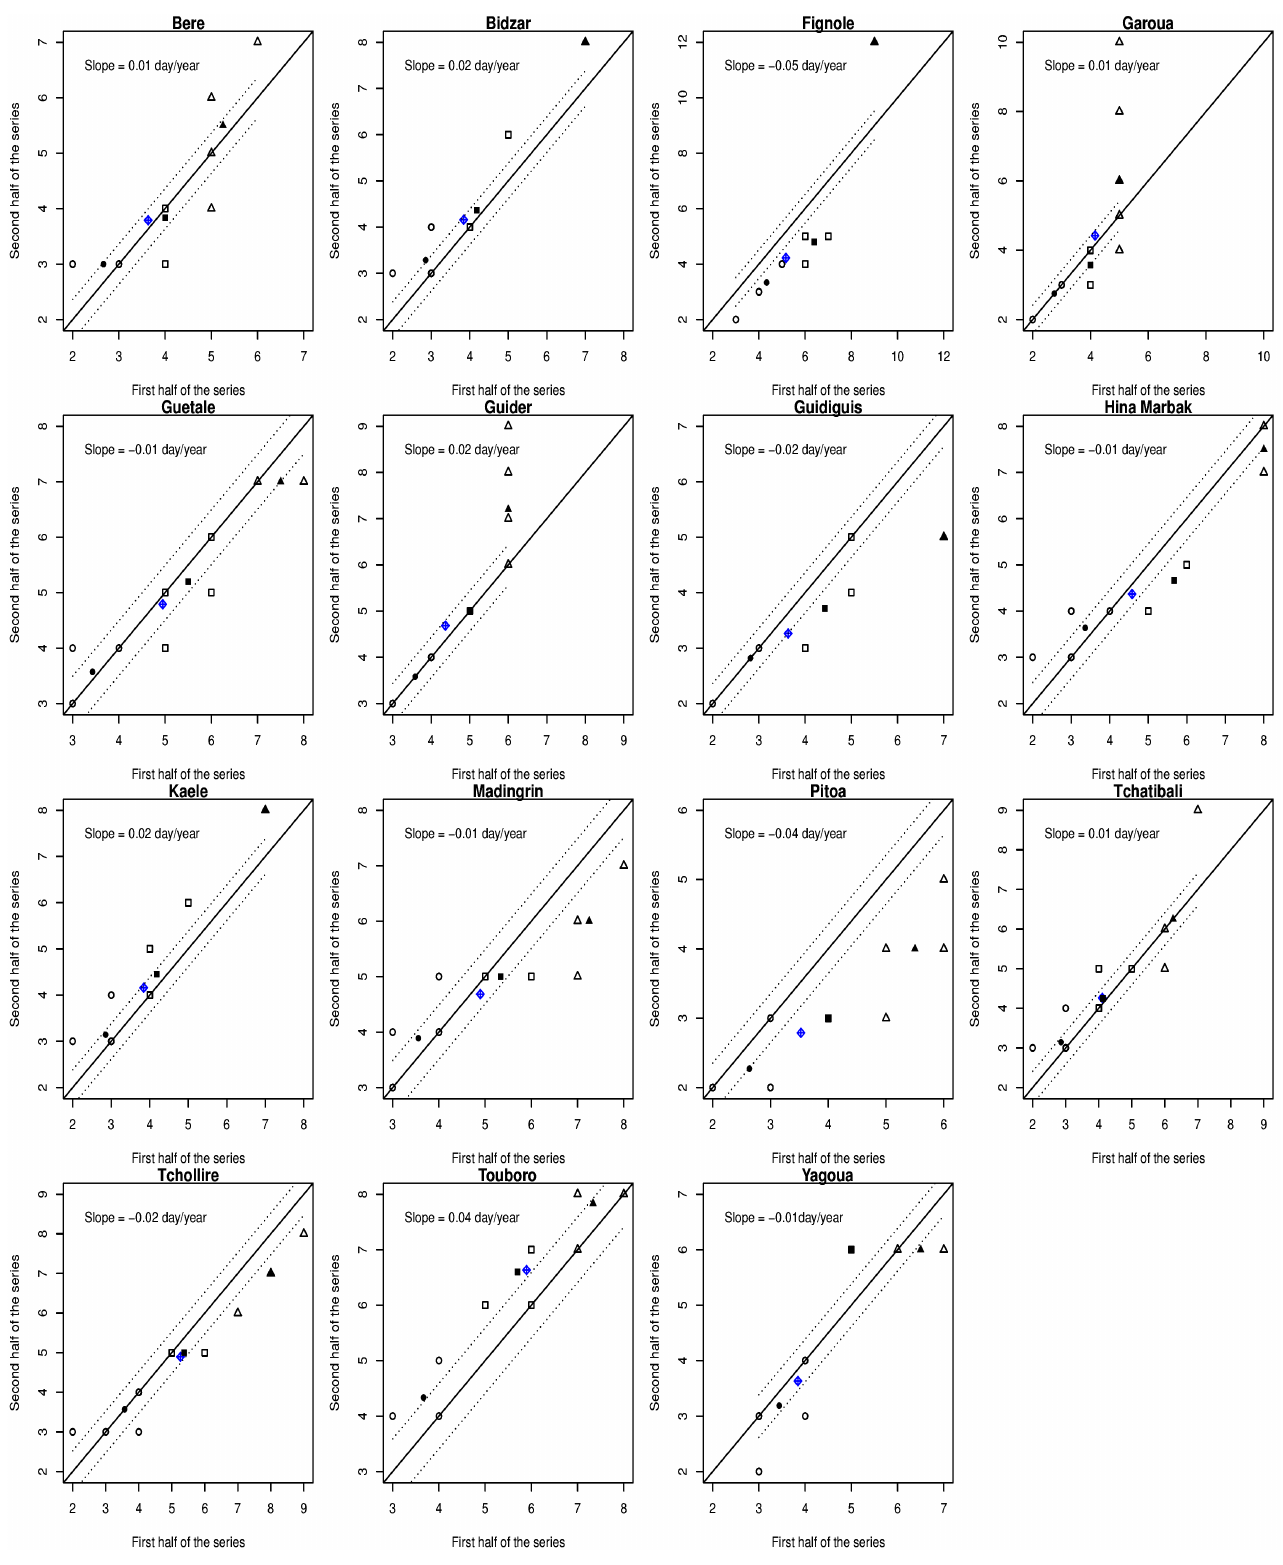
Figure 13. As in Figure 12, but for CWD.